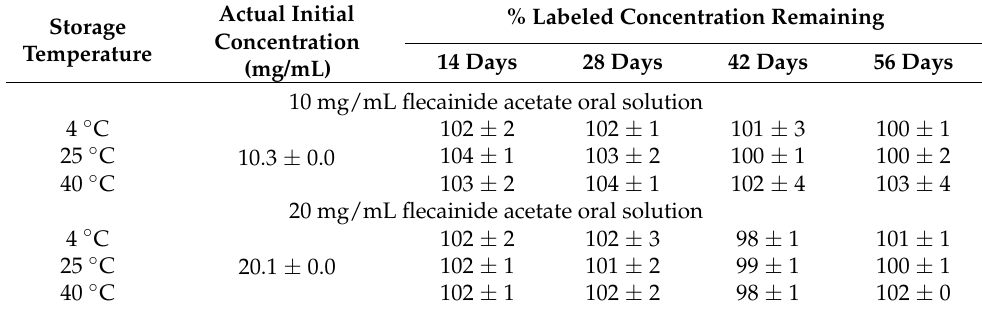
Table 2. Stability data of flecainide acetate oral solutions at different temperatures using F3 as a vehicle. Mean ± SD ( n =